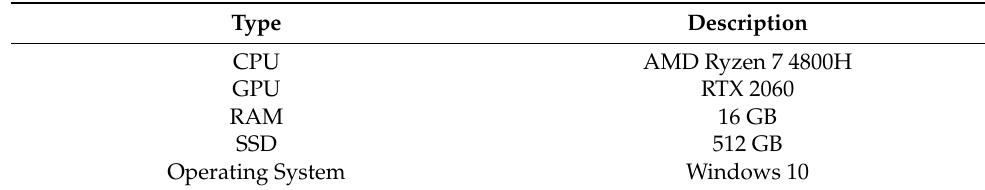
Table 7. Experiment